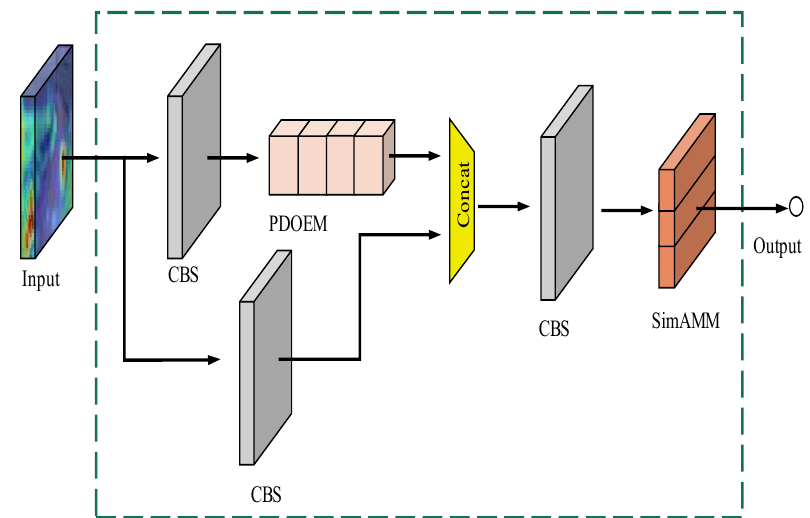
Figure 3. BP-Sim bottleneck structure feature extraction structure.